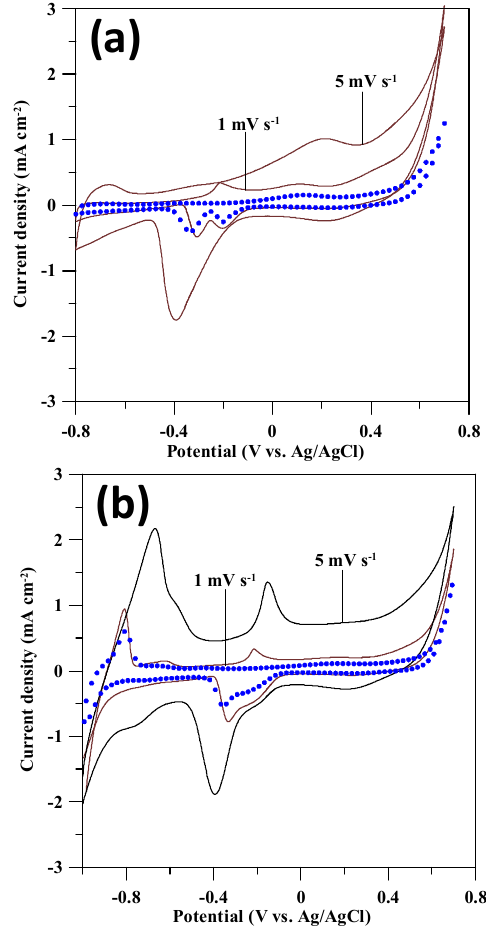
Figure 6. CV profiles of ( a ) Pd-GS and ( b ) Pd-rGO catalyst electrodes in 0.1 M NaOH + 0.1 M glucose. The symbols represent the CV profiles measured at 1 mV · s − 1 in 0.1 M NaOH without glucose.